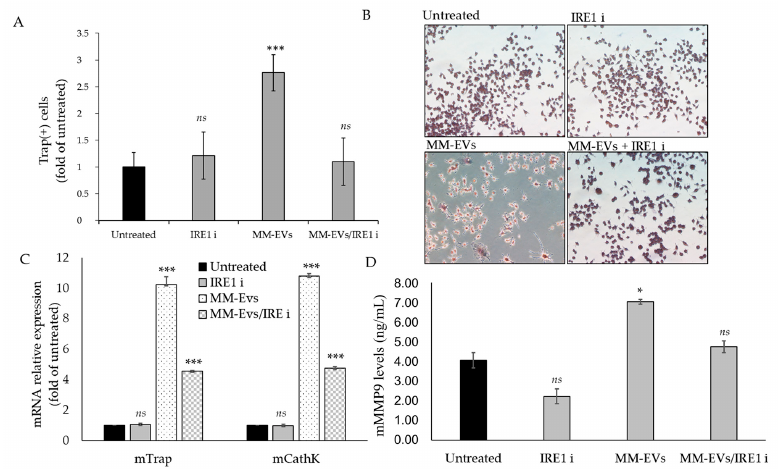
Figure 4. ( A ). Trap staining assay in Raw264.7 cells untreated or treated for 6 days with 25 µ g / mL of MM-EVs, with 200 nM GSK2850163 (IRE1 ι ) and co-treated with MM-EVs and IRE1 ι . ( B ). Representative images of TRAP + Raw264.7 cells (original magnification 20 × ). ( C ). qRT-PCR analysis of Trap and Cathk in Raw264.7 cells treated for 6 days with 25 µ g / mL of MM-EVs, with 200 nM GSK2850163 (IRE1 ι ) and co-treated with MM-EVs and IRE1 ι . ( D ). ELISA assay of mMMP9 protein levels in conditioned medium of Raw264.7 cells treated for 6 days with 25 µ g / mL of MM-EVs, with 200 nM GSK2850163 (IRE1 ι ) and co-treated with MM-EVs and IRE1 ι . The statistical significance of the di ff erences was analyzed using a Dunnett’s test (treated Groups vs. Untreated Group) (* p -value < 0.05, *** p -value < 0.0005, ns not significant). Cancers 2020 , 12 , x